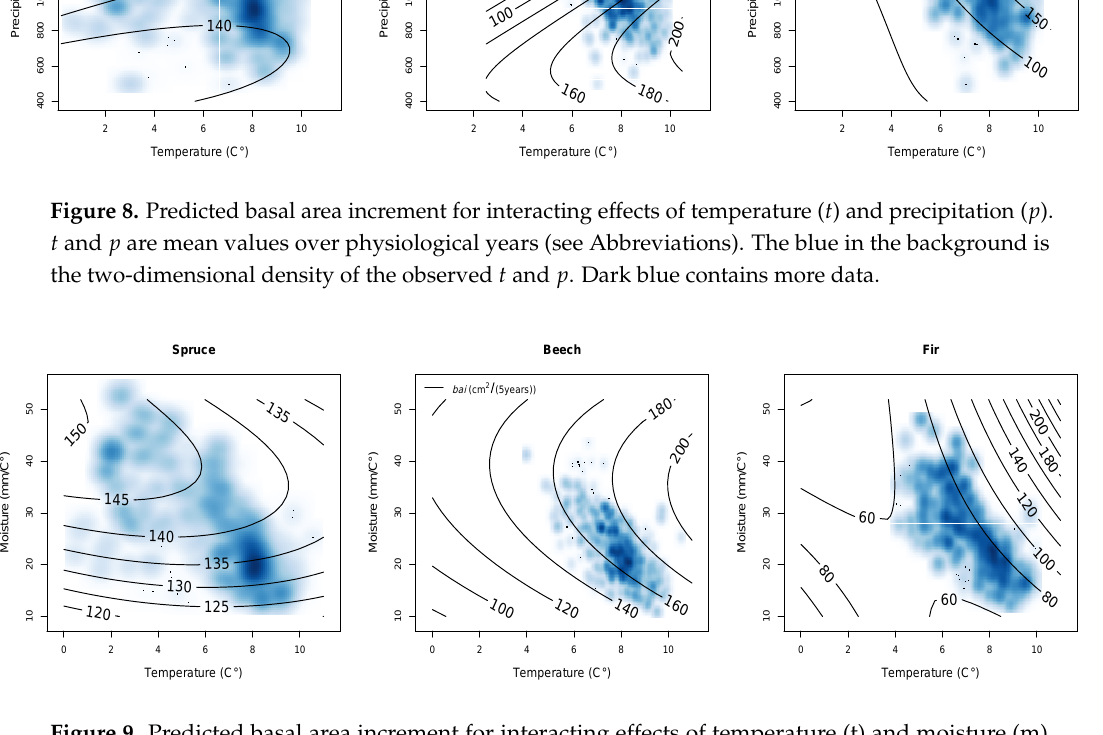
Figure 9. Predicted basal area increment for interacting effects of temperature (t) and moisture (m). Temperature is the mean value over physiological years, moisture is the mean over spring months (see